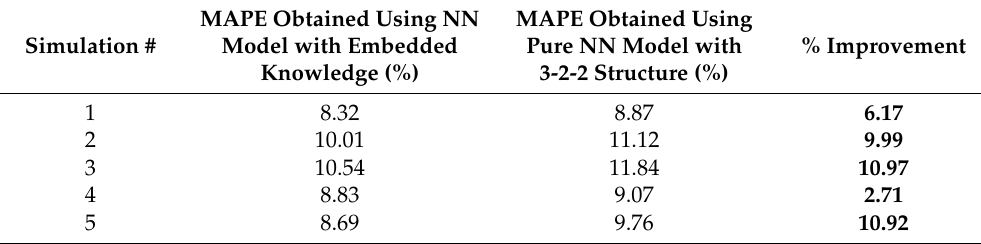
Table 2. Comparison of the MAPE obtained for the test set using the pure NN model with a 3-2-2 structure and the NN model with embedded knowledge.